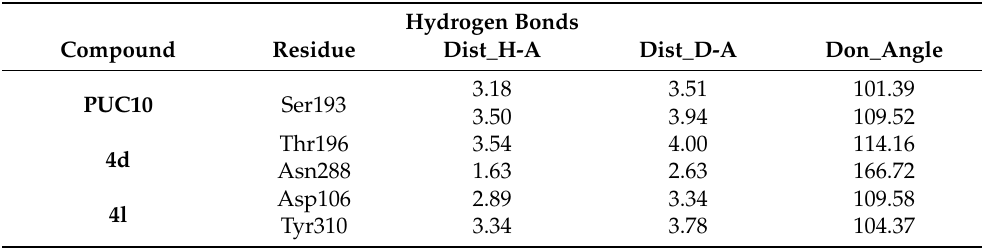
Table 4. Hydrogen bond interactions established with residues within the binding site and com- pounds PUC10 , 4d and 4l .